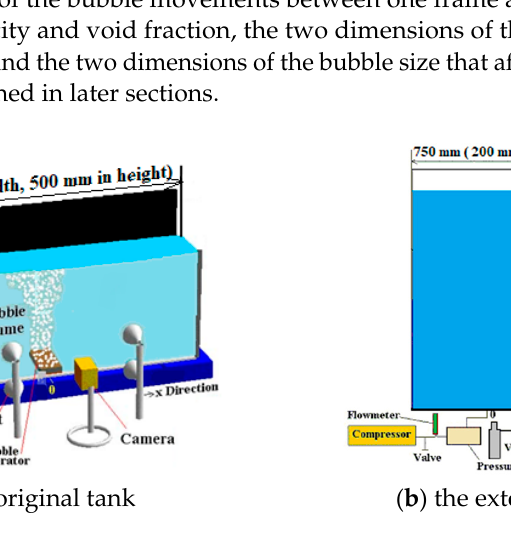
Figure 1. Schematic diagram of experimental apparatus. Table 1. Experimental conditions.